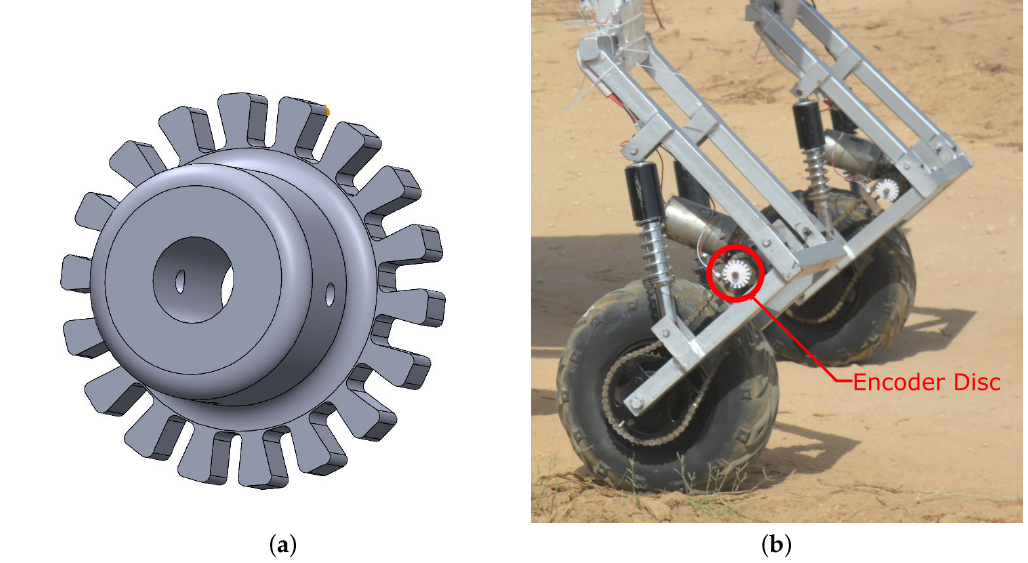
Figure 2. ( a ) CAD of the customized encoder disc and ( b ) Encoder disc (White) installed on the robot. After design finalization, the system is introduced with its translational and rota- tional joints to carry out motion control commands. While generating a Unified Robotics Description Format (URDF), the definition of the robotics’ joints is required, as well as their axis of rotation through an extensible markup language (XML) specification and on Solidworks. There are two joints hoarded in each limb to ensure the effective translation of the vehicle. For all joints, the defined axis of rotation is the y-axis. This is because the drawing originates from the